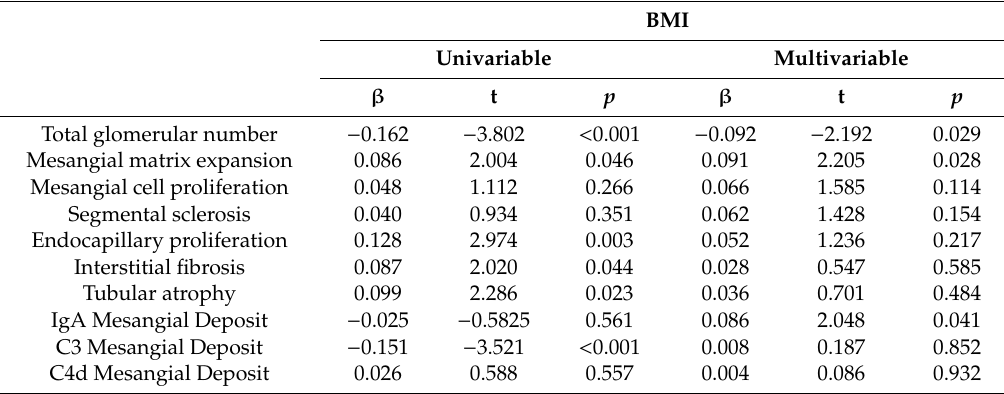
Table 4. Linear regression analysis for BMI and the histopathologic